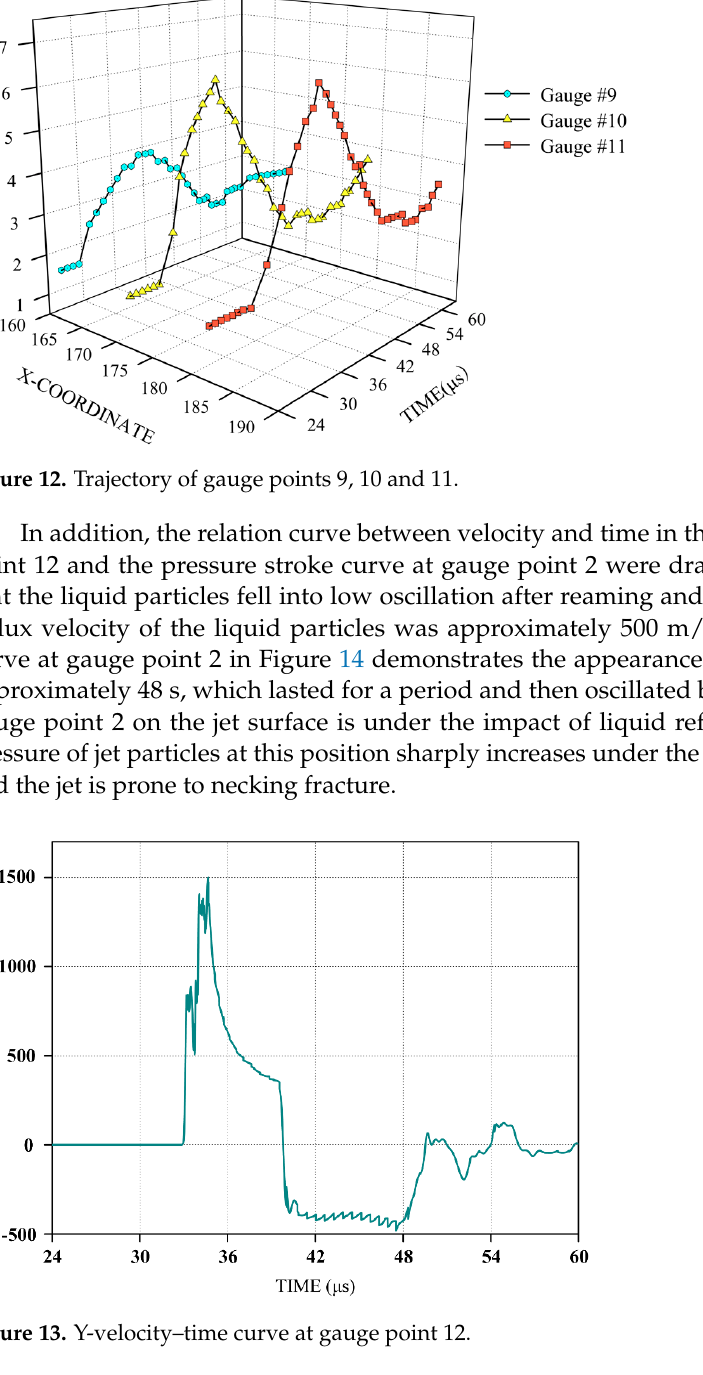
Figure 14. Pressure–time curve at gauge point2. The simulation results demonstrate the generation and propagation of the initial shock wave, side-wall reflection wave, bottom plate reflection wave, side-wall secondary reflection wave, and reflux of liquid particles driven by the shock wave. The simulation results verify the previous theoretical analysis. Specifically, the interference of liquid in the jet includes the following three parts: side-wall reflection interference, bottom plate reflection interference, and side-wall secondary reflection interference. 4. Experiments and Calculation 4.1. X-ray Experiment X-ray tests were conducted on the process of jet penetration in the LFCS to verify the accuracy of the theoretical model. The size parameters of the LFCS used in the test are shown in Figure 15. The LFCS mainly consisted of a metal shell with a cavity, a liquid filler, a cover plate, and a sealing strip, which were connected by screws. Here, the liquid filler was water, while the shell